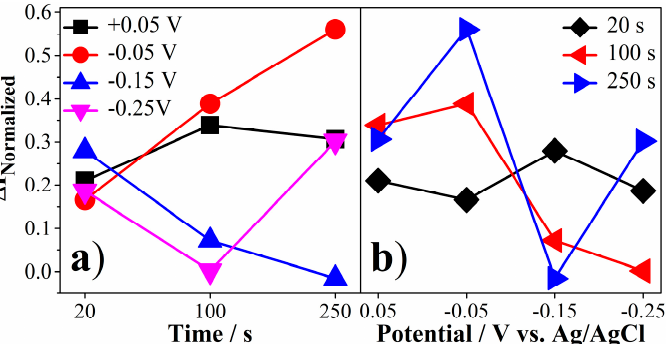
Figure 7. Two-factor factorial design results in the electrodeposition of AuNPs. ( a ) Normalized current vs. time of electrodeposition at +0.05 V ( (cid:4) ), − 0.05 V ( • ), − 0.15 V ( (cid:78) ) and − 0.25 V ( (cid:72) ). ( b ) Normalized current vs. applied potential at 20 s ( (cid:73) ), 100 s ( (cid:74) ) and 250 s ( (cid:7)